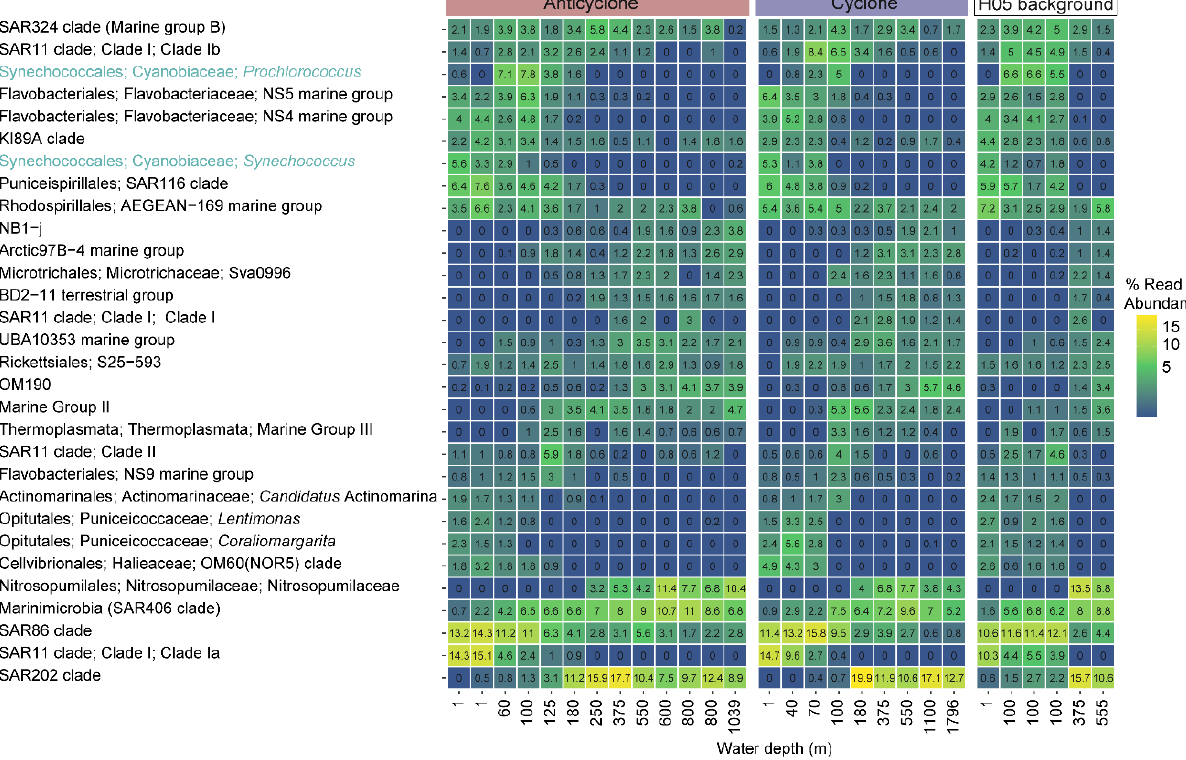
Figure 4. The relative abundance of the 30 most abundant bacterial and archaeal genera collected in cyclonic and anticyclonic eddies and an uninfluenced background station in the southeastern Mediterranean Sea during October 2018, as estimated by read abundance. Results of replicate casts at anticyclone and uninfluenced background (H05) stations are shown in columns with identical